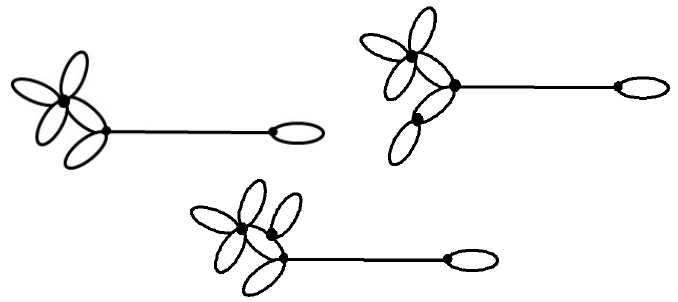
Figure 5 The graphs B 2[3] , 1 , B 2[3 , 1] , 1 and B 2[3;1] ,